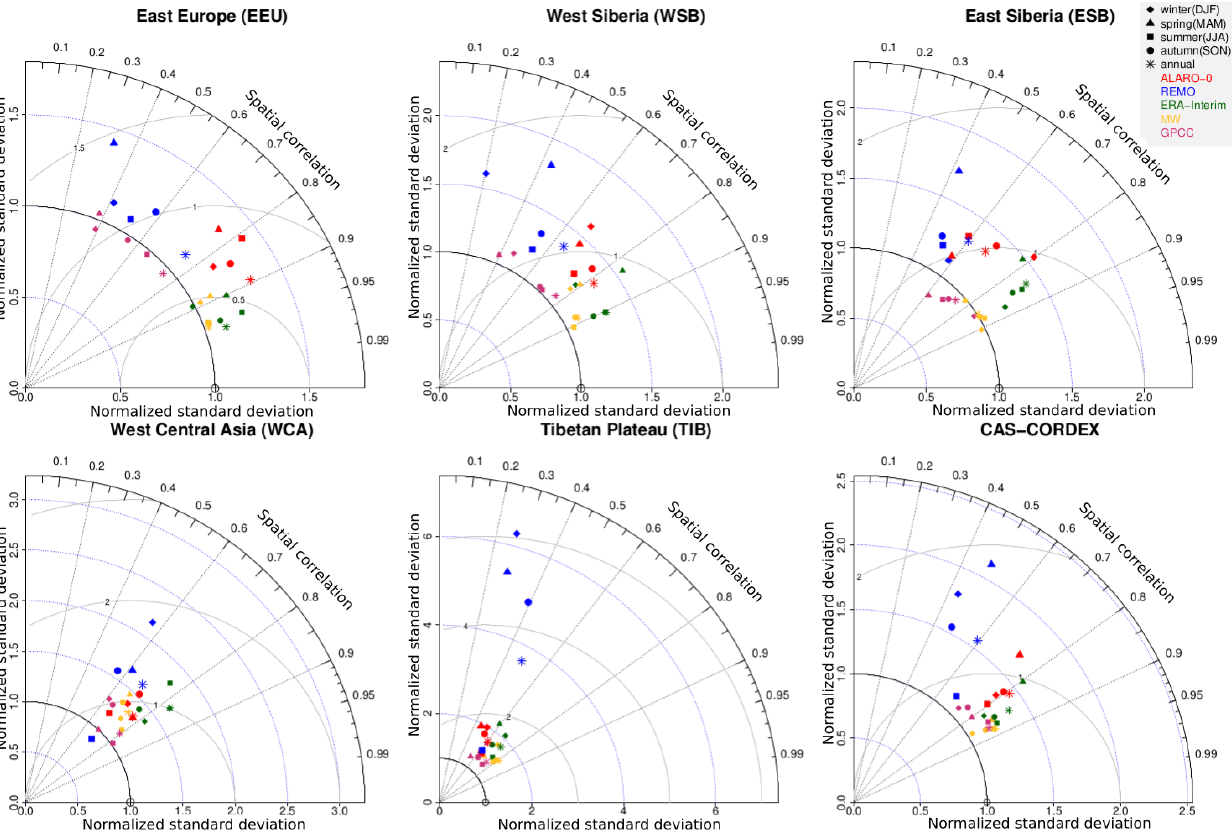
Figure 11. Normalized Taylor diagram showing the model performance in terms of precipitation for seasonal and annual means for both RCMs (ALARO-0 and REMO), gridded observational datasets (MW, GPCC), and the ERA-Interim reanalysis data with respect to CRU for the five subregions and the CAS-CORDEX